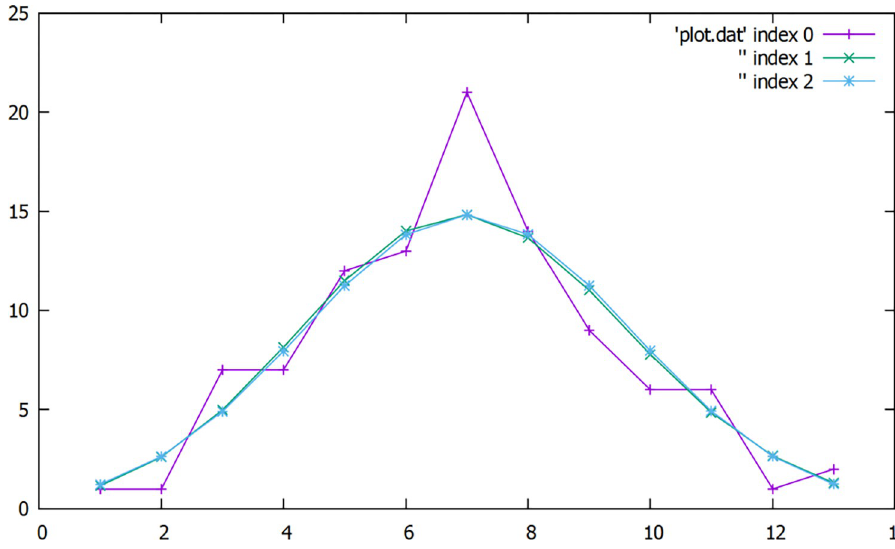
Fig 2. Gnuplot of binned results outputted by RadStat from experiment (purple), Poisson estimation (green) and normal approximation (blue). The x and y-axis represent the bin number and counts in each bin,